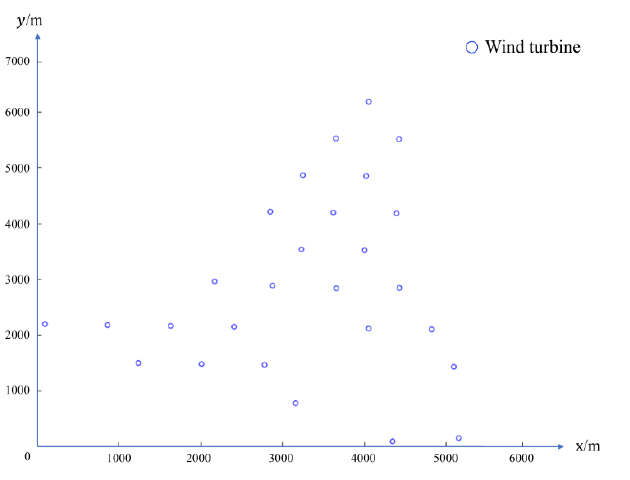
Figure 5. The layout diagram of wind turbines in a coordinate plane.